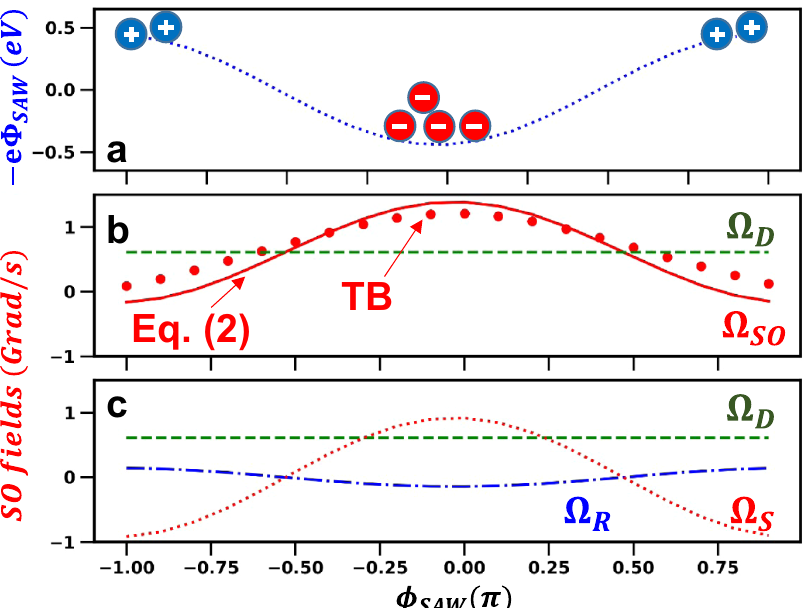
Fig.5|Tight-bindingcalculationsofthespinprecessionrate. SAWphase( ϕ SAW ) dependence of the ( a ) electronic piezoelectric energy ( − e Φ SAW , dotted blue line) and of the ( b ) electron-spin precession frequencydetermined by the tight-binding (TB)approachforaQWwiththesamethicknessastheQWRunder P SAW =100W/m (dots). The solid red line yields the total SO fi eld Ω SO obtained from the analytical